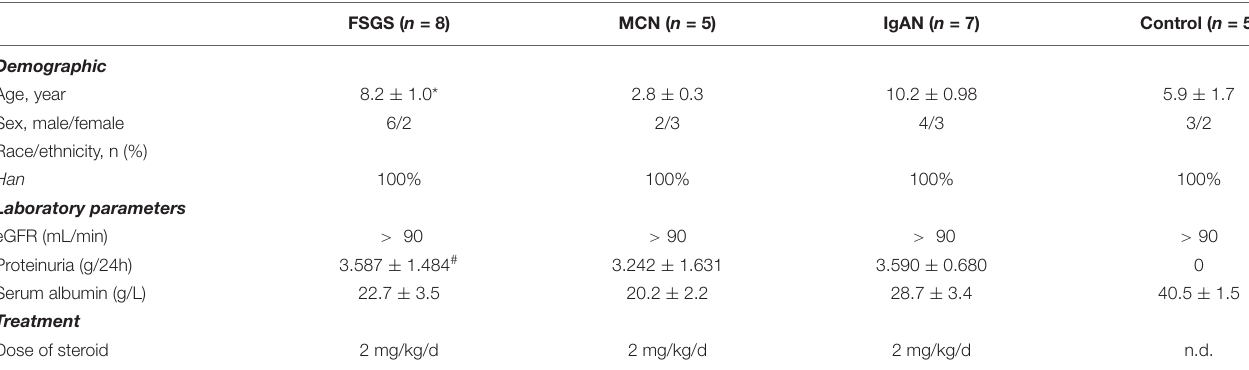
TABLE 1 | Clinical and laboratory characteristics of study